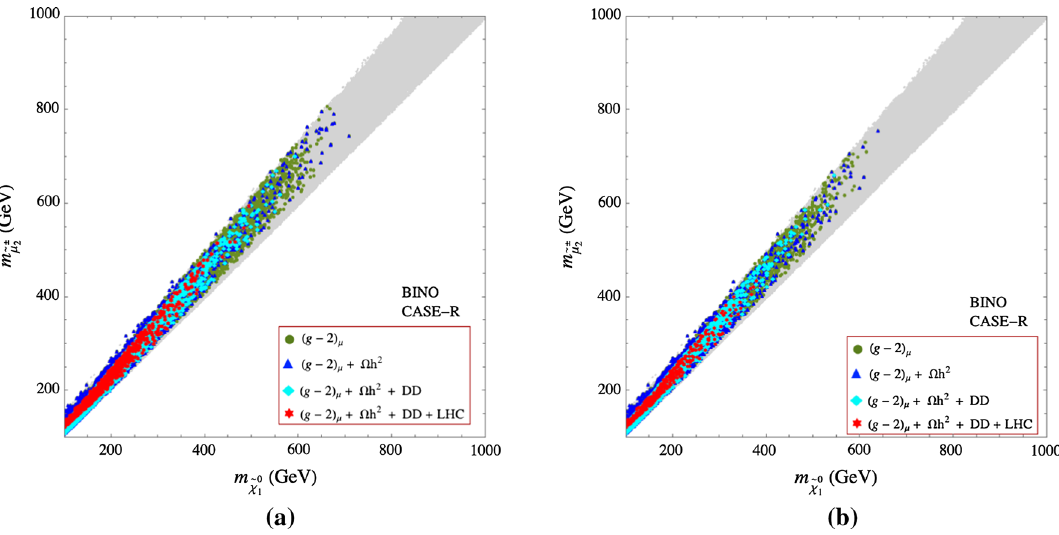
Fig. 18 The results of our parameter scan in the m ˜ χ 0 limits (right) from ( g − 2 ) μ . The color coding is as in Fig. 15